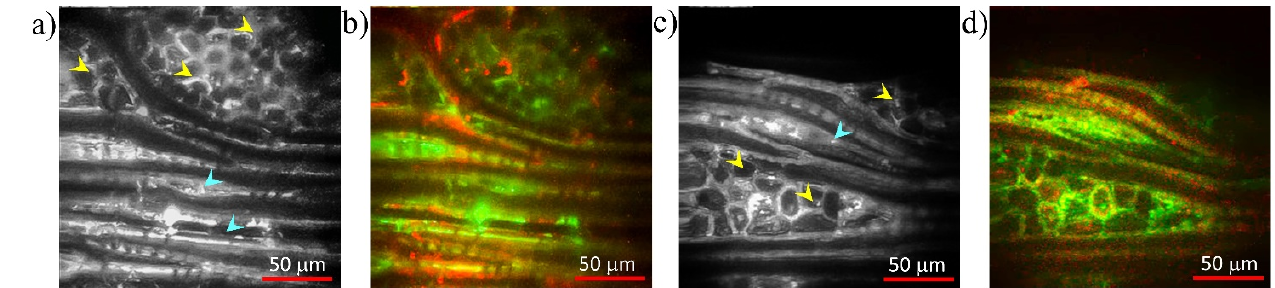
Figure 4. Beech NLO microscopy images (excitation wavelength 850 nm), showing the fibers (light- blue arrowheads) in the tangential section and the aggregates of parenchyma rays (yellow arrow- heads) in the transverse section. Images are obtained from the maximum-intensity projection over all acquired images in a stack (101 μ m scanning depth; 1 μ m sampling step), thus enhancing the visualization of the inner details. ( a , c ) TPEF and SHG signals generated from lignin and cellulose/starch are optically summed. ( b , d ) Merged TPEF/SHG image showing the morphology of rays and fibers, as well as the distribution of SHG and fluorescence emitters.